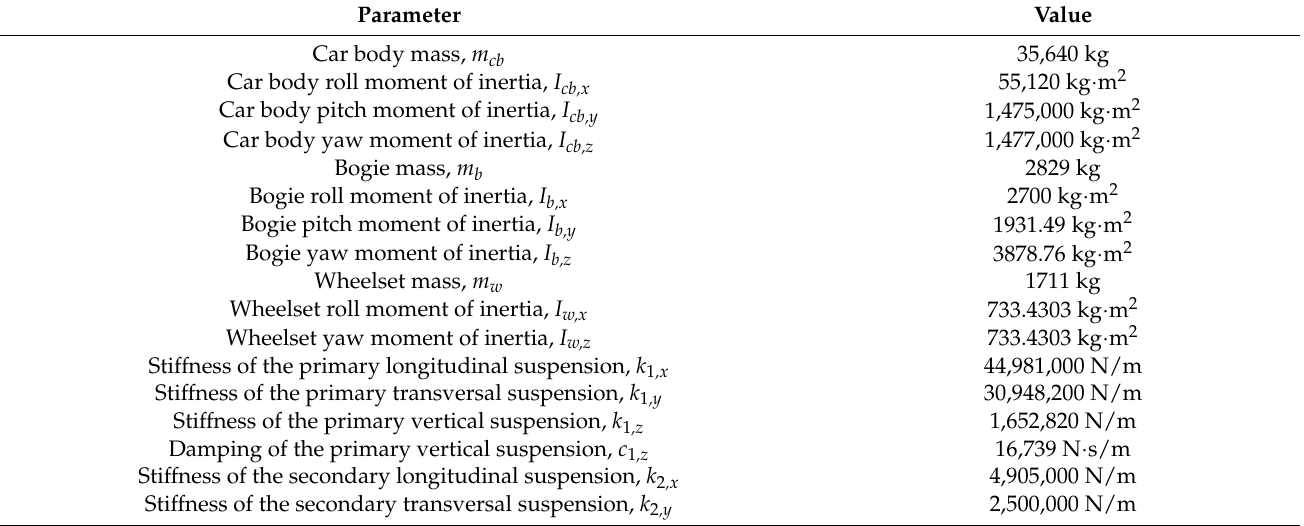
Table 1. Parameters for the Alfa Pendular vehicle (adapted from Neto et al. (2020) [39]).